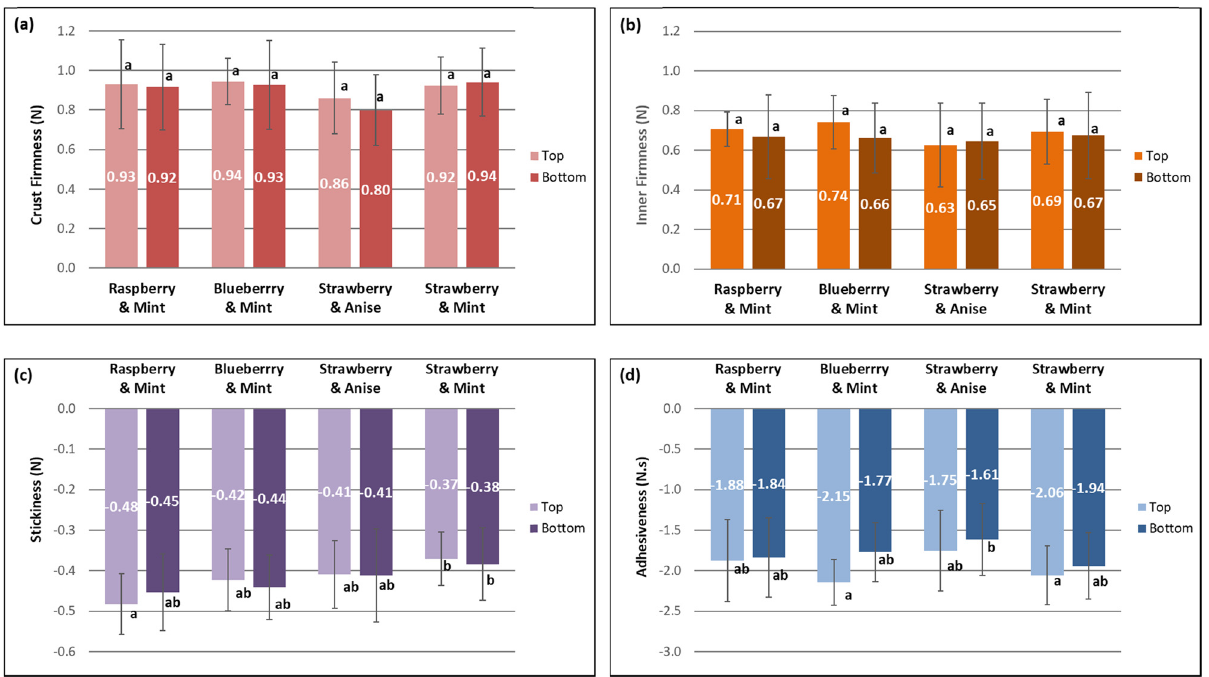
Figure 5: Textural properties on top and bottom faces of the jelly gums, obtained by the puncture test: ( a ) crust fi rmness, ( b ) inner fi rmness, ( c ) stickiness and ( d ) adhesiveness ( bars with the same letter are not statistically di ff erent at 5% signi fi cance level – ANOVA with Tukey test )